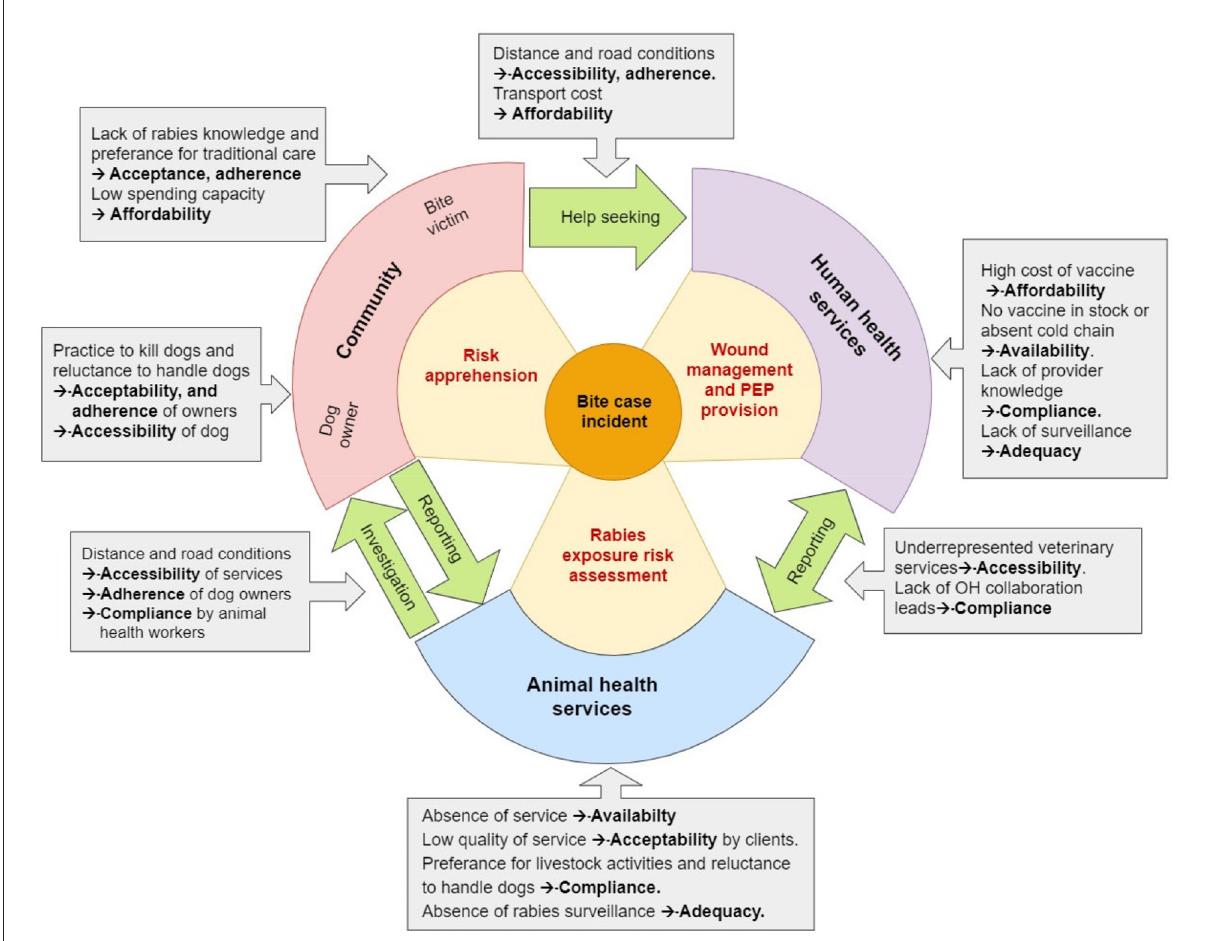
FIGURE2 IBCM access cycle introduced in the introduction (Figure 1). This time the gray boxes highlight the barriers identified by level and linkage followed after an arrow by the corresponding access elements they